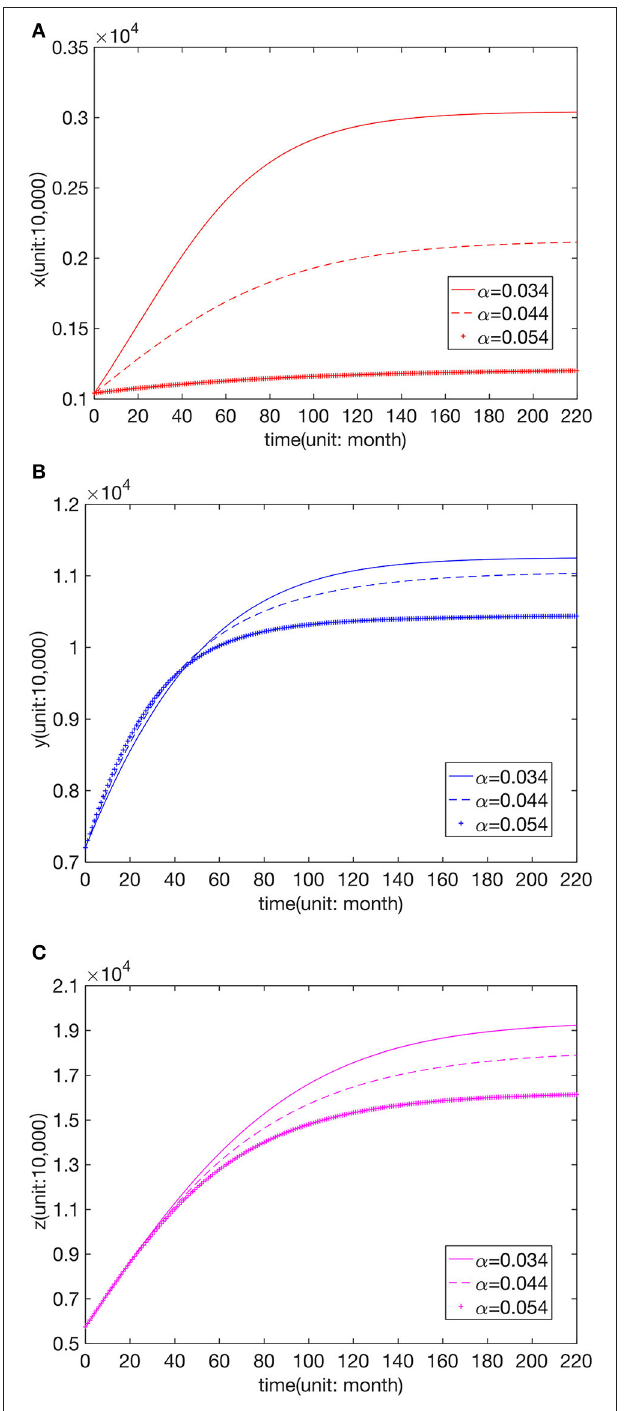
FIGURE 4 | Effect of parameter value β on the number of visits to (A) FLHs, (B) SLHs, and (C)